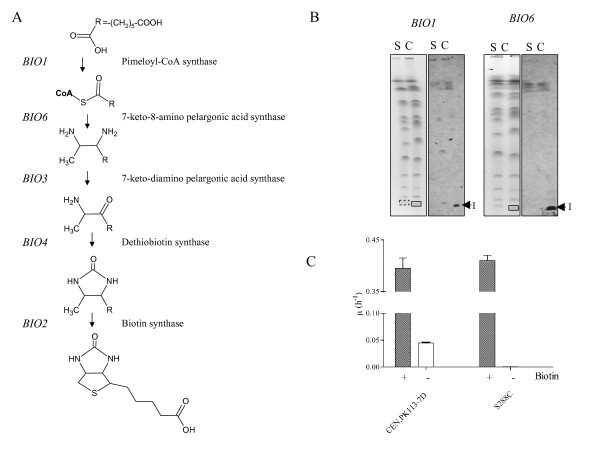
Biotin biosynthesis characterization in CEN.PK113-7D and S288C. A) Biotin biosynthesis pathway in CEN.PK113-7D. B) Southern blotting of S288C and CEN.PK113-7D chromosomes using specific probes for BIO1 and BIO6 genes. C) Maximal specific growth rate of CEN.PK113-7D and S288C in shake flask cultivations with synthetic medium [62] in absence (white bar), and presence (grey bar) of biotin. Growth rates were calculated from biomass measurements expressed as optical density measured at 660 nm.